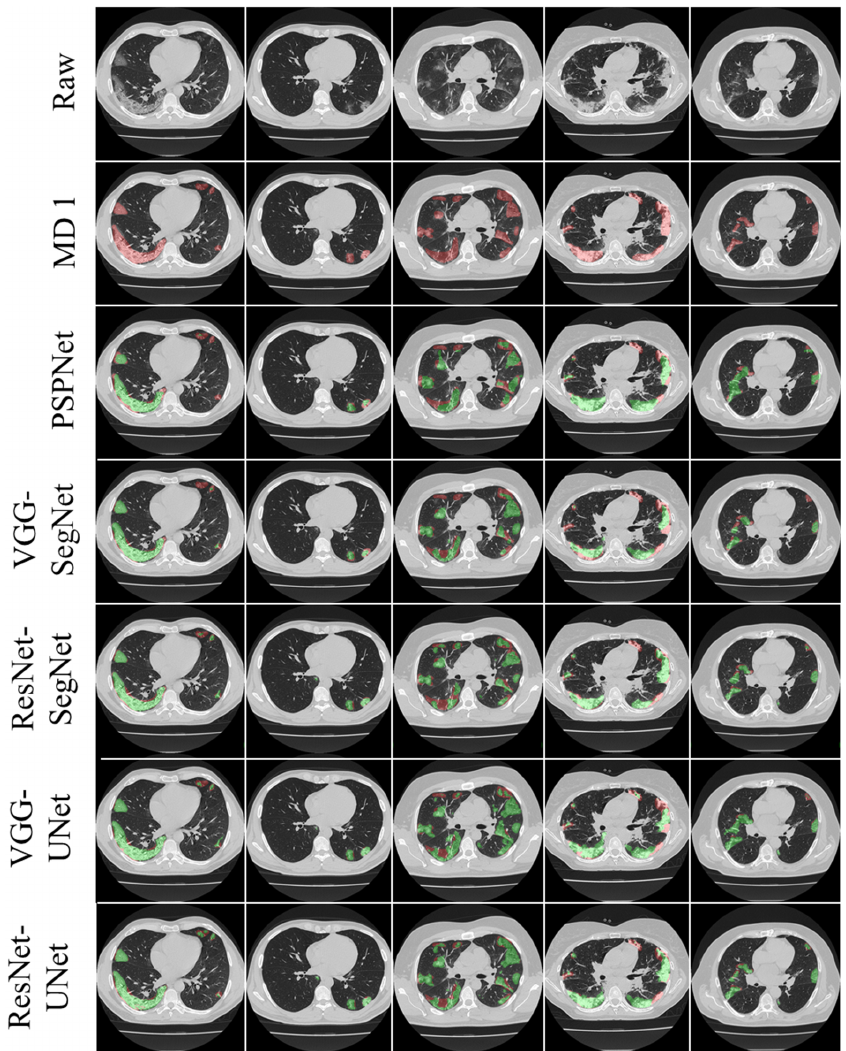
Figure 11. Row 1: raw CT; row 2: MD 1 (gold standard); rows 3–7: overlay images—AI (green) over MD (red). The 5 AI models are PSPNet (row 3), VGG ‐ SegNet (row 4), ResNet ‐ SegNet (row 5), VGG ‐ UNet (row 6), and ResNet ‐ UNet (row 7).